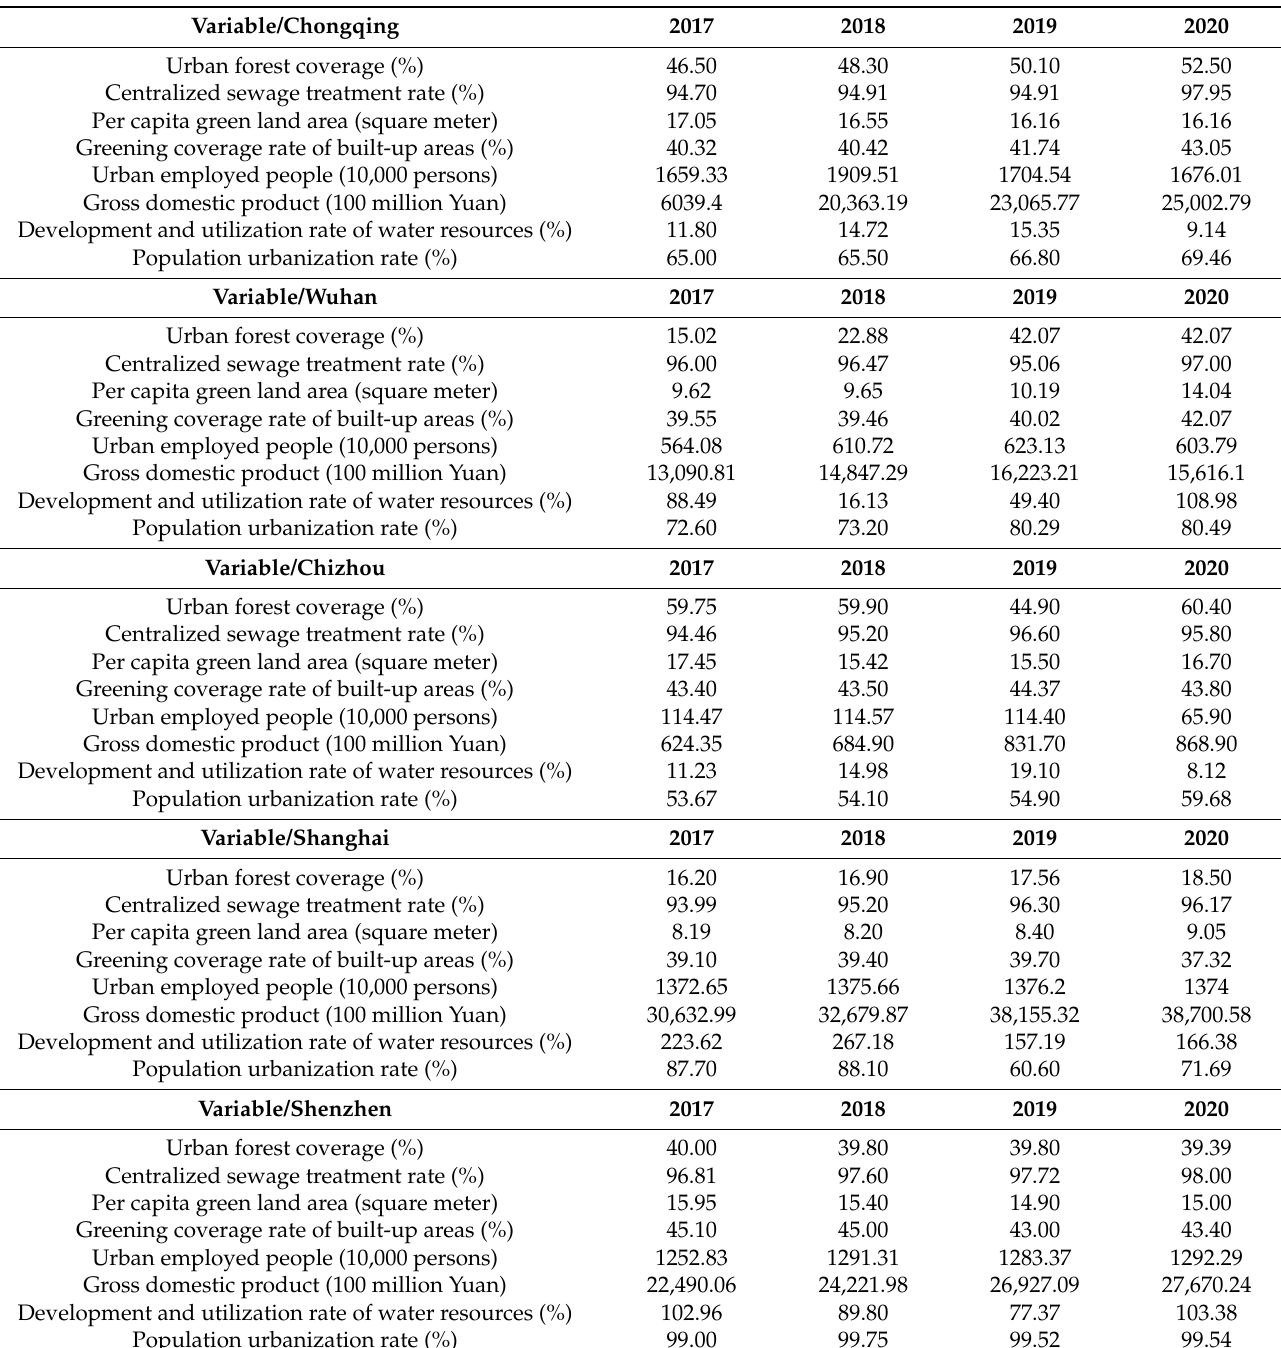
Table A1. Original values of main variables in 11 pilots from 2017 to